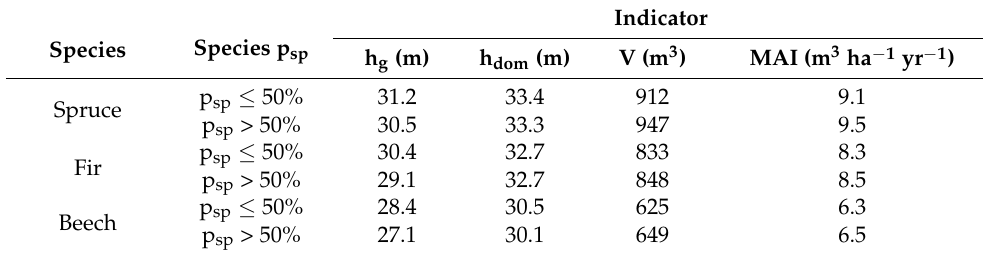
Table 7. Yield indicators of mixed stands at 100 years.